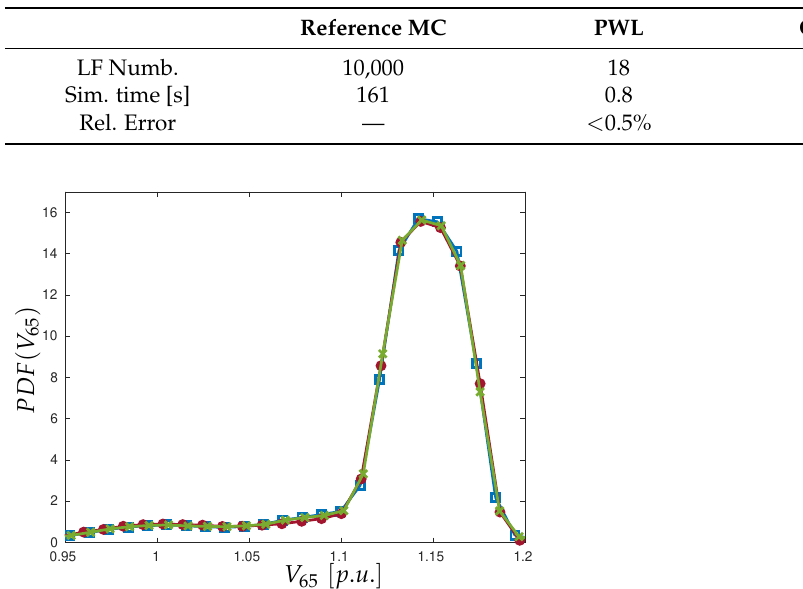
Figure 10. Detail of the PDF ( V 65 ) at Bus-65: (Square blue marker) computed with reference MC; (Dot red marker) computed with PWL method; (Green cross marker) computed with Copula and gPC (for expansion order β = 2).